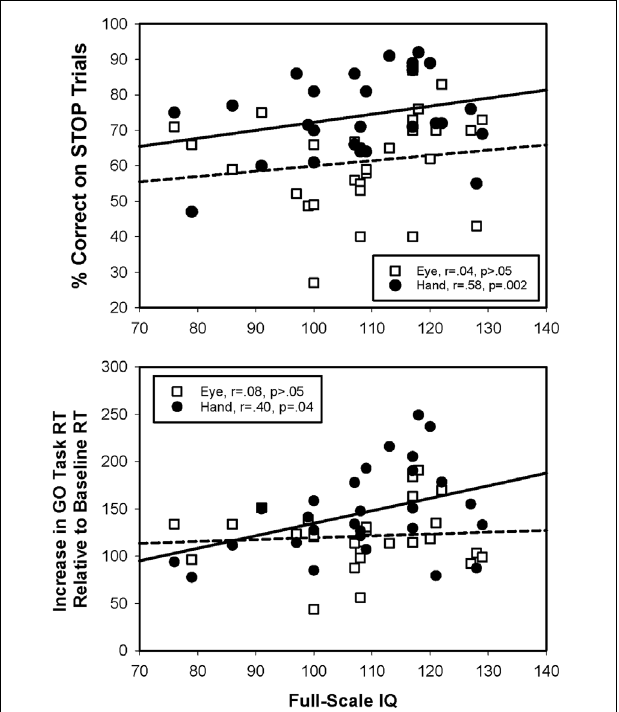
FIGURE 6 | Relationships between Stop Signal test performance and general intellectual ability. Greater general intellectual ability was associated with greater stopping accuracy for hand, but not for eye movements. Also, greater general intellectual ability was associated with greater slowing of reaction times from baseline GO trials to Stop Signal GO trials for the hand, but not the